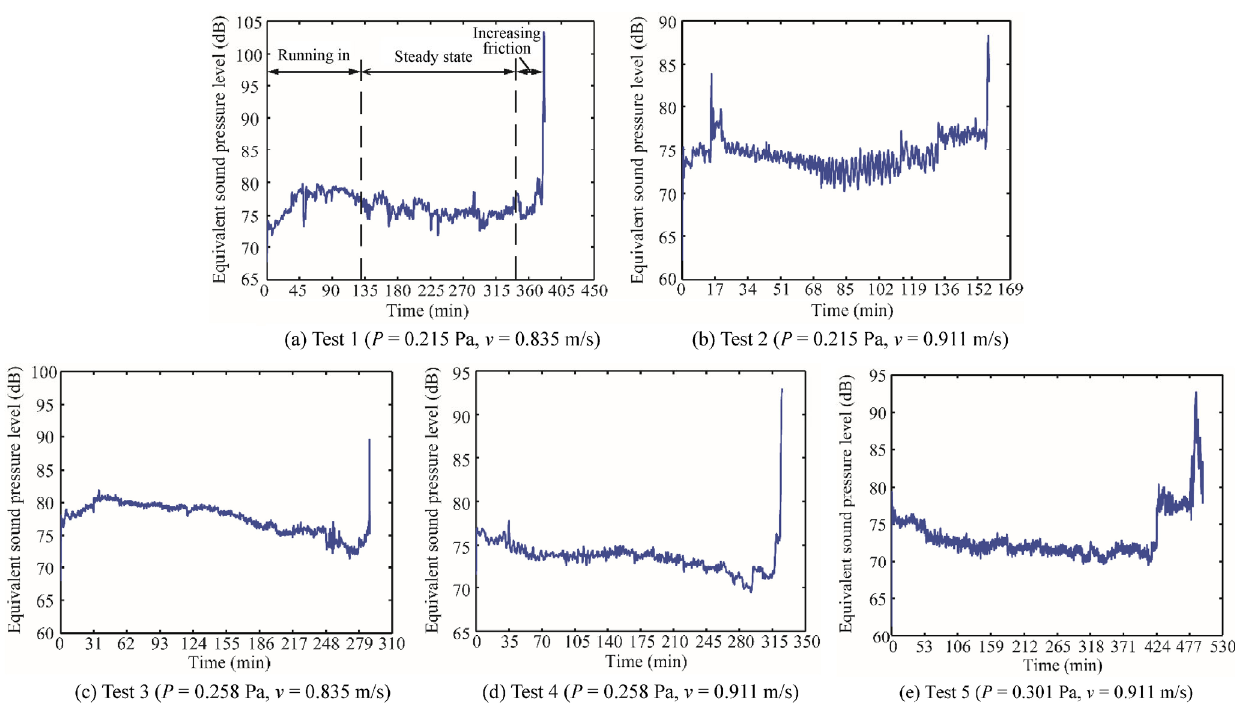
Fig. 5 Friction force and friction noise signals in the rotating friction